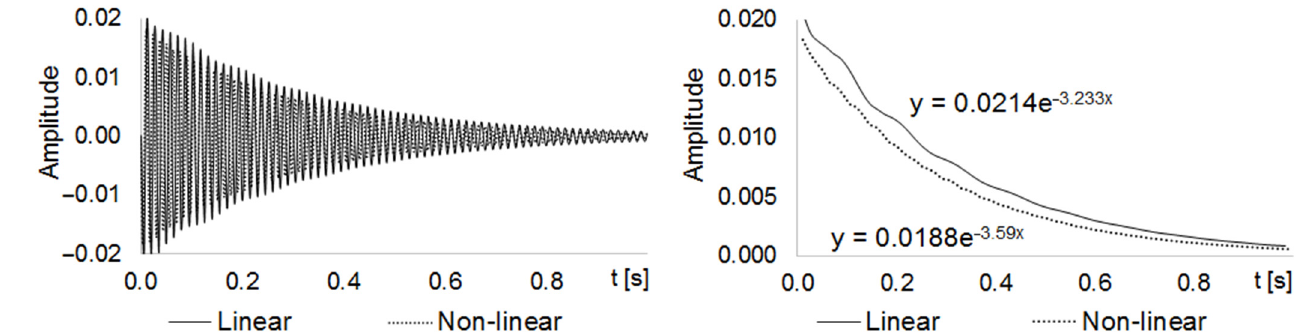
Figure 8. Linear and nonlinear z-dir displacement ( left ) and decaying rate ( right ) curves.